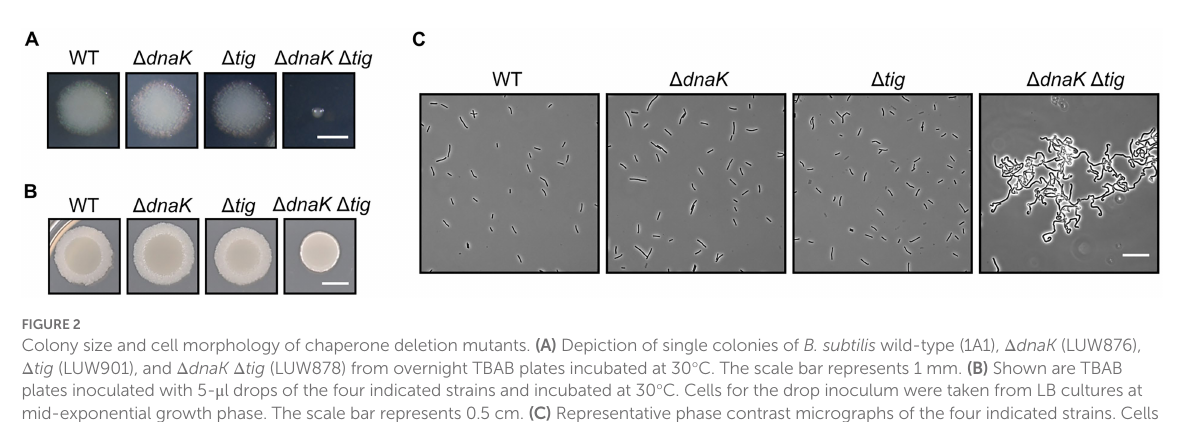
Supplementary Data Sheet 1. To verify that low intensity